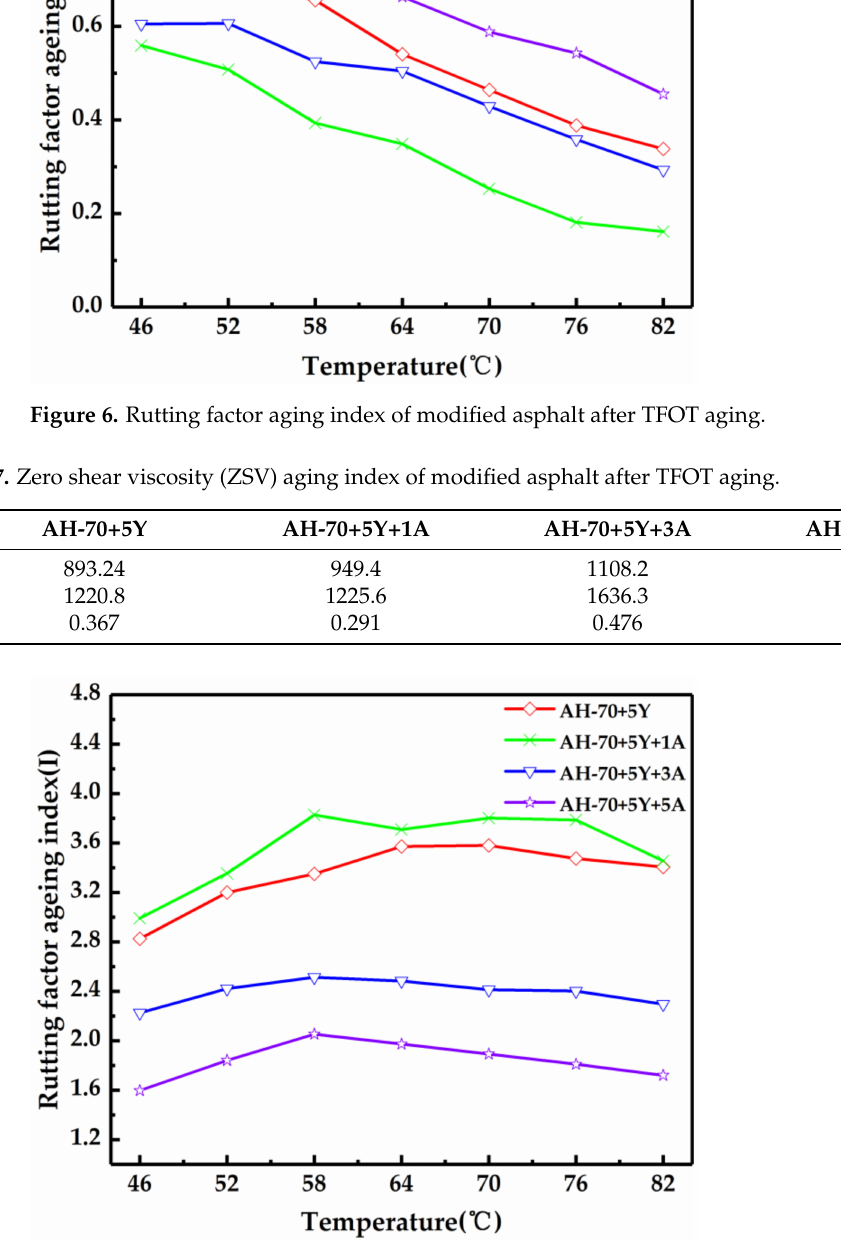
Figure 7. Rutting factor aging index of modified asphalt after pressure aging vessel (PAV) aging. Table 8. ZSV aging index of modified asphalt after PAV